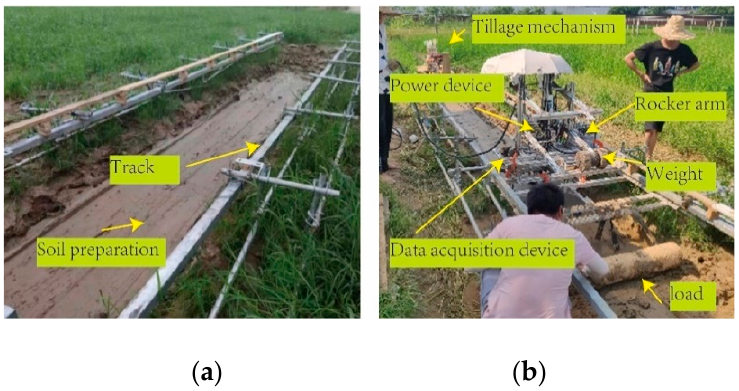
Figure 3. Test bench. ( a ) Track device, ( b ) Single wheel bench